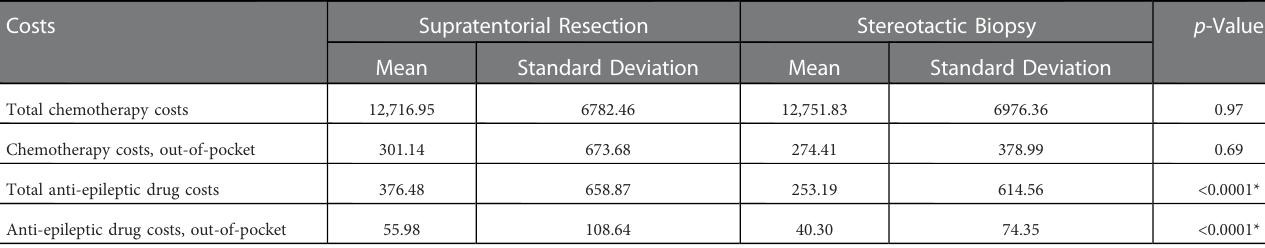
TABLE 5 Seizure and chemotherapy drug costs, 90-days